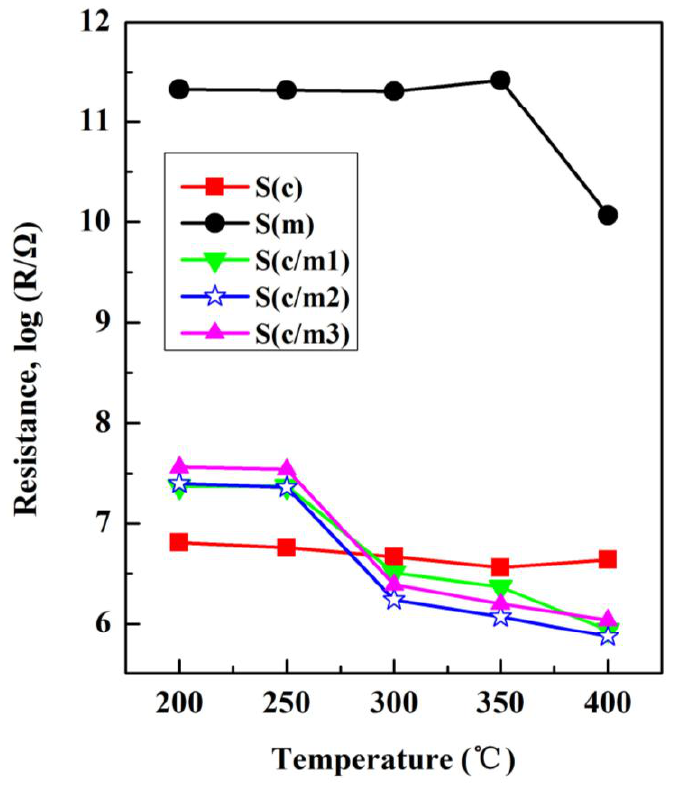
Figure 11. Temperature dependence of the resistances of the gas sensors in air.